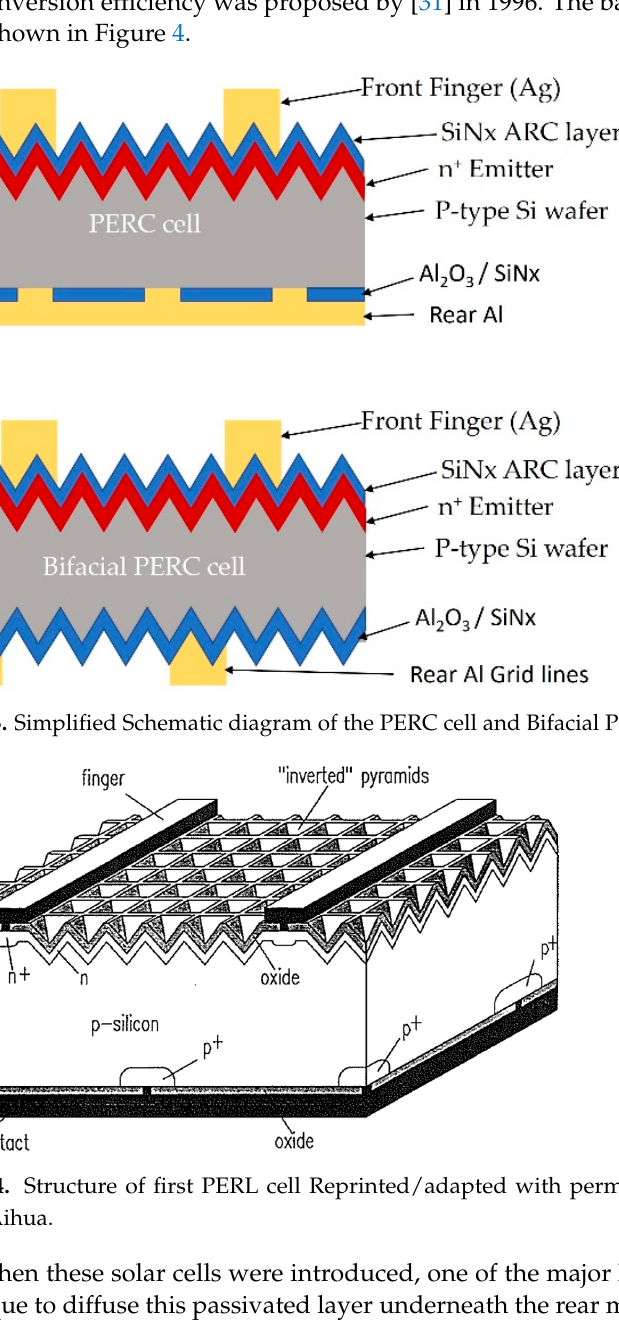
Figure 4. Structure of first PERL cell Reprinted/adapted with permission from Ref. [30]. 1992, Wang, Aihua.